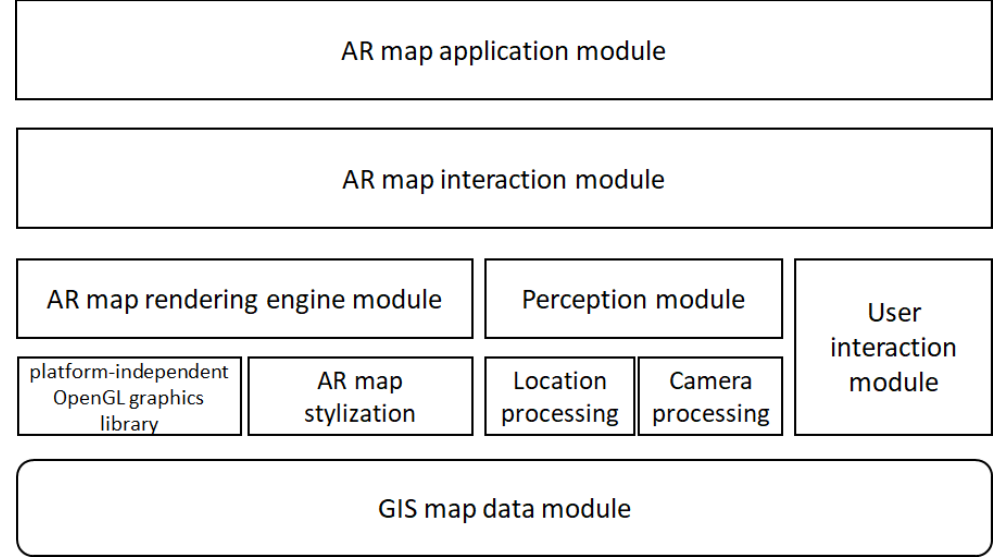
Figure 2. Architecture of AUGL.